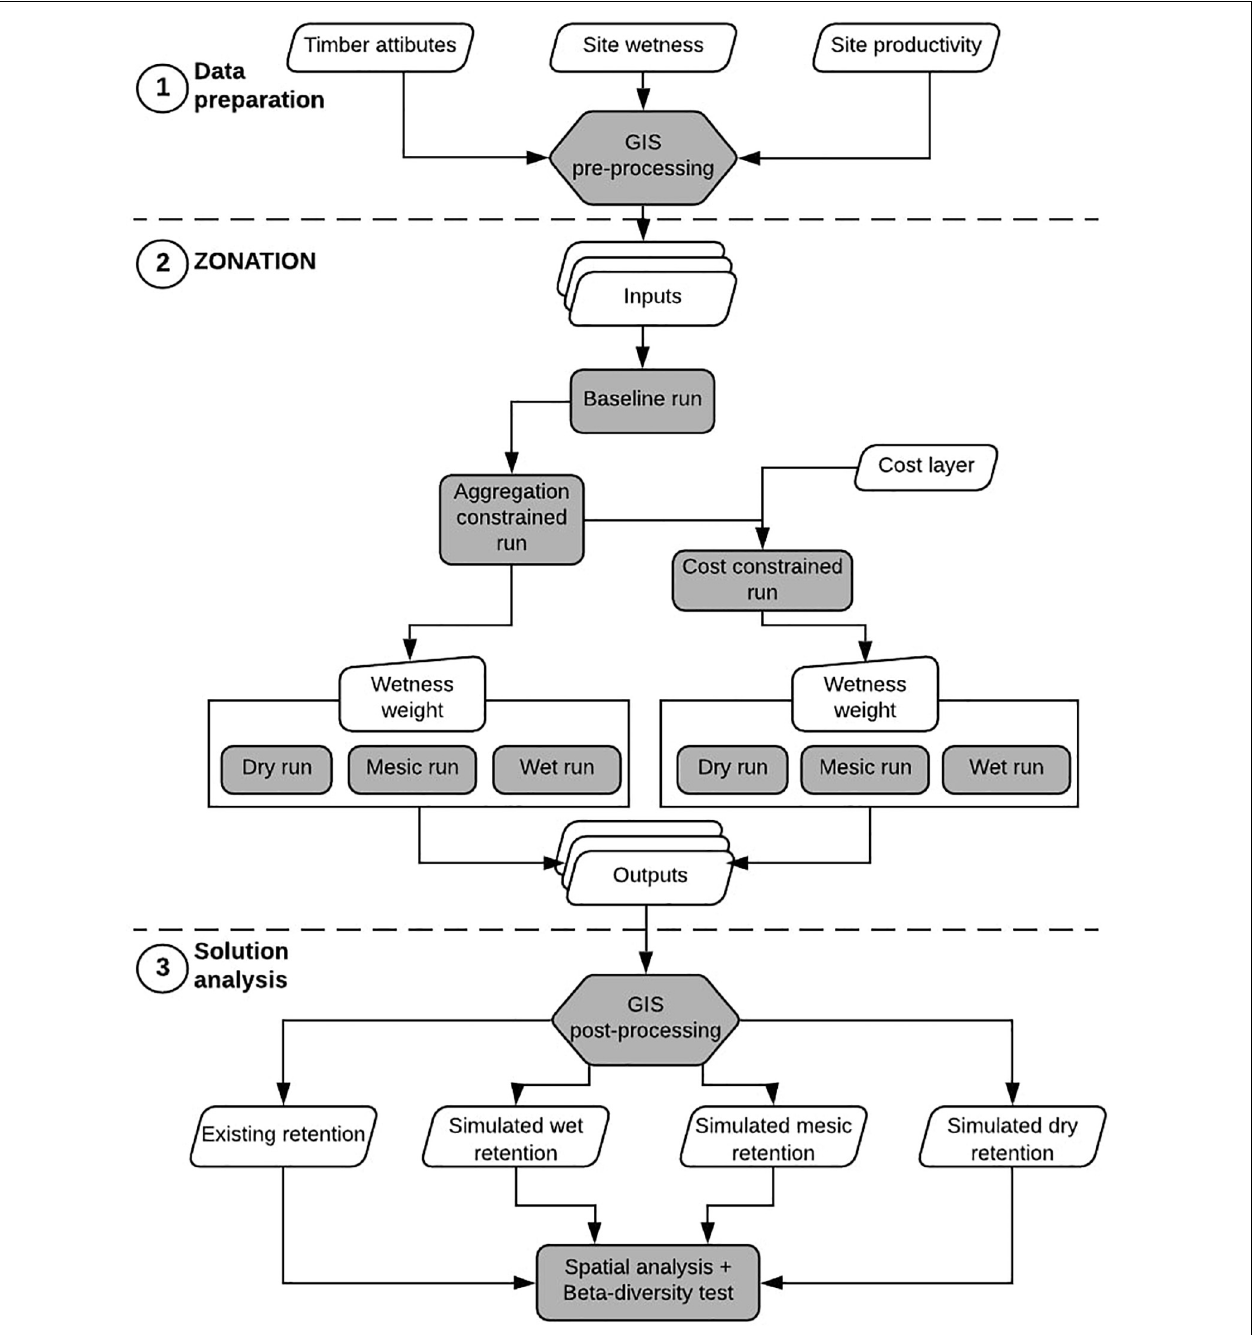
FIGURE 2 | Systematic retention p lanning flowchart representing the method used in this study. Step 1 was conducted in ArcGIS10.5 and step 3 was conducted in both ArcGIS10.5 and R3.6.3.